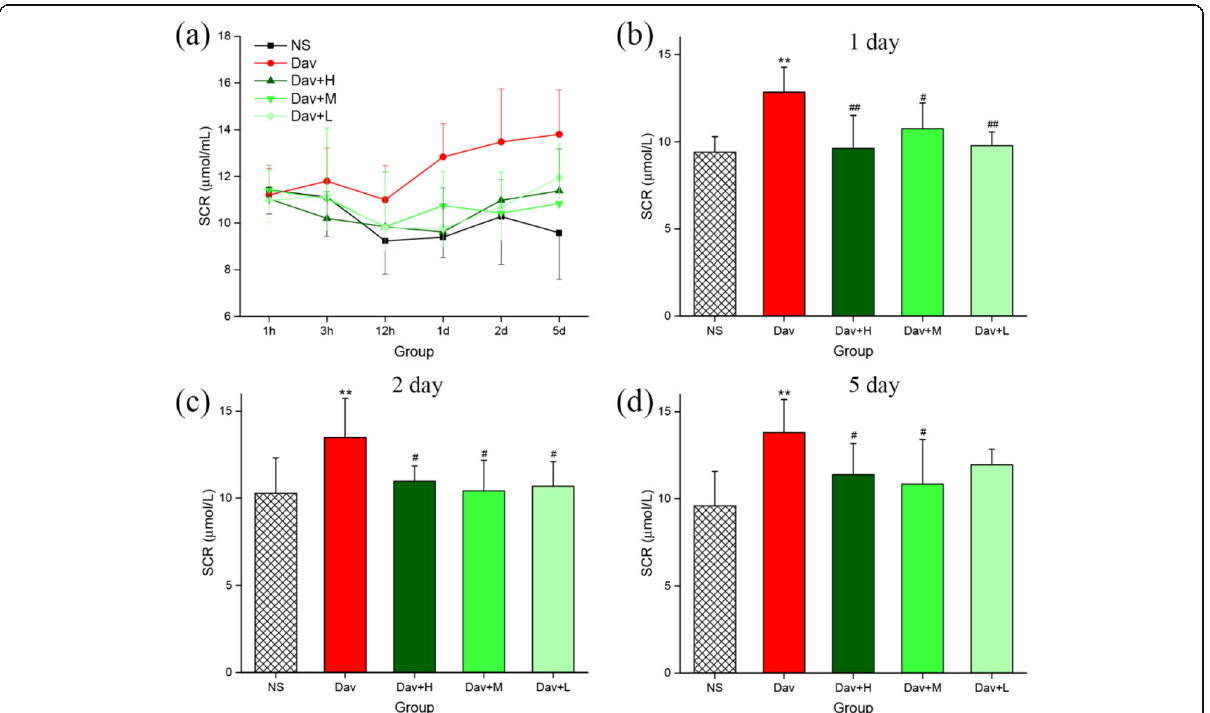
Fig. 7 Effects of Phellodendri Chinensis Cortex Carbonisata-carbon dots (PCCC-CDs) on serum creatinine (SCR). a SCR concentration changes in 1 h, 3 h, 12 h, 1 day, 2 days, and 5 days. The levels of SCR in ( b ) 1 day ( c ) 2 days ( d ) 5 days. Mice were treated with normal saline (NS), D.acutus venom (Dav, 1 mg/kg) and high (H), medium (M), and low (L) doses of PCCC-CDs + Dav (1 mg/kg). Data are represented as mean ± SD of six animals of each group. * p < 0.05 and ** p < 0.01 compared with control group treated with normal saline (NS). # p < 0.05 compared with